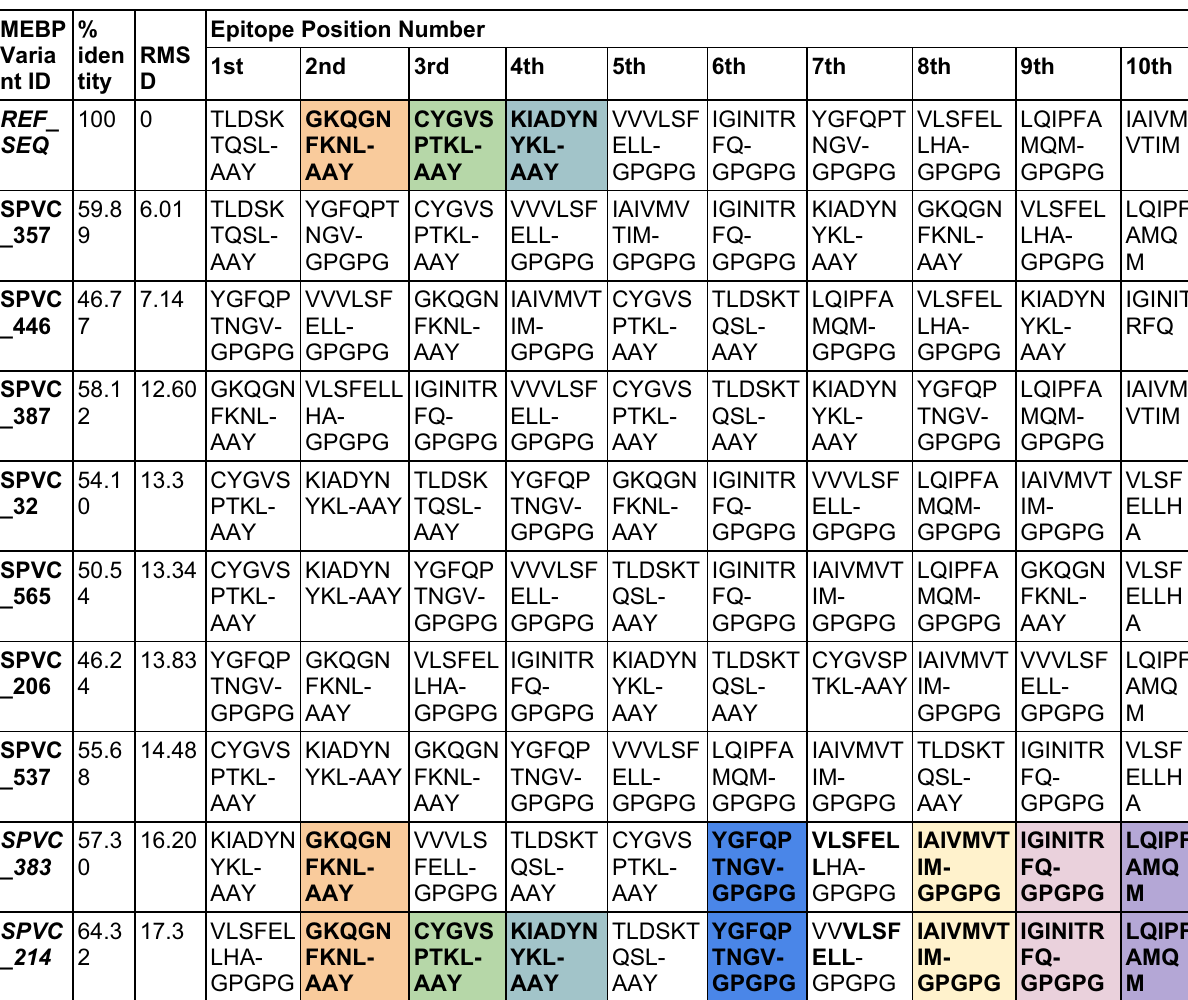
Table 3. Comparative epitope positions in the ten MEBP variants with % identity and RMSD with reference to REF_SEQ MEBPVC. Three comparisons are highlighted in this table (1) REF_SEQ vs SPVC_383, (2) REF_SEQ